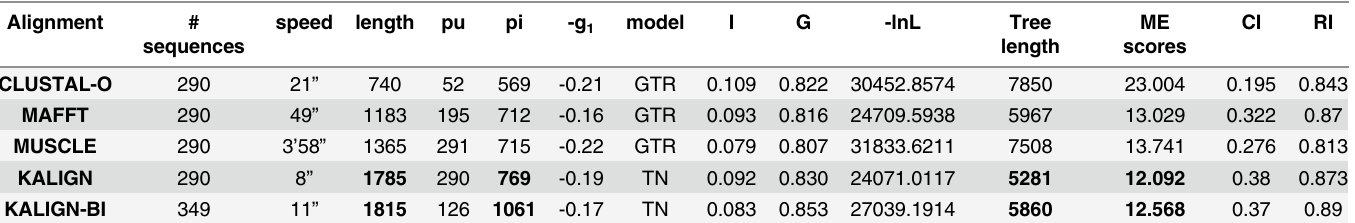
Table 1. Sequence and alignment statistics. Pu, parsimony uninformative characters; pi, parsimony informative characters;-g 1 statistics, the amount of phylogenetic signal versus noise; model, model of molecular evolution inferred by Modeltest; I, proportion of invariable sites; G, gamma distribution shape parameter alpha;-lnL, maximum likelihood tree score; tree length, the minimum number of substitutions over all sites for a given topology; ME, Minimum evo- lution score; CI, consistency index (the amount of homoplasy given the data; equals 1 when there is no homoplasy); RI, retention index (the amount of synap- omorphy on the tree; increased values from 0 to 1 suggest increased evidence of